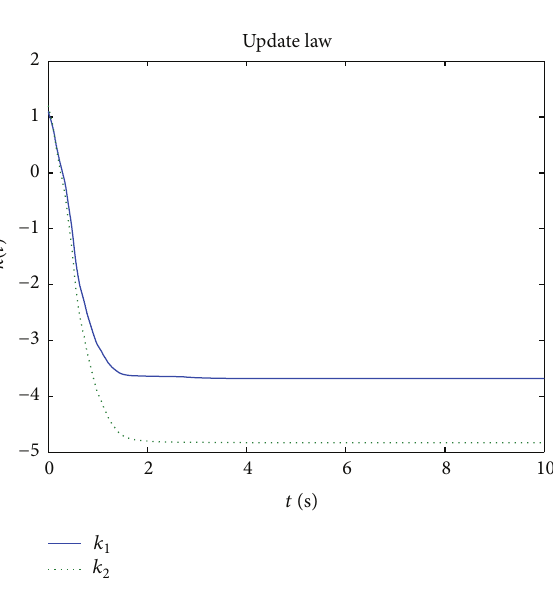
Figure 4: Update